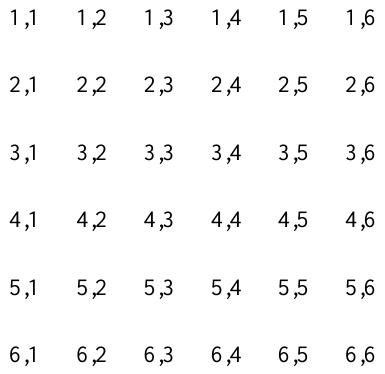
Figure 3. A 6 × 6 image matrix.